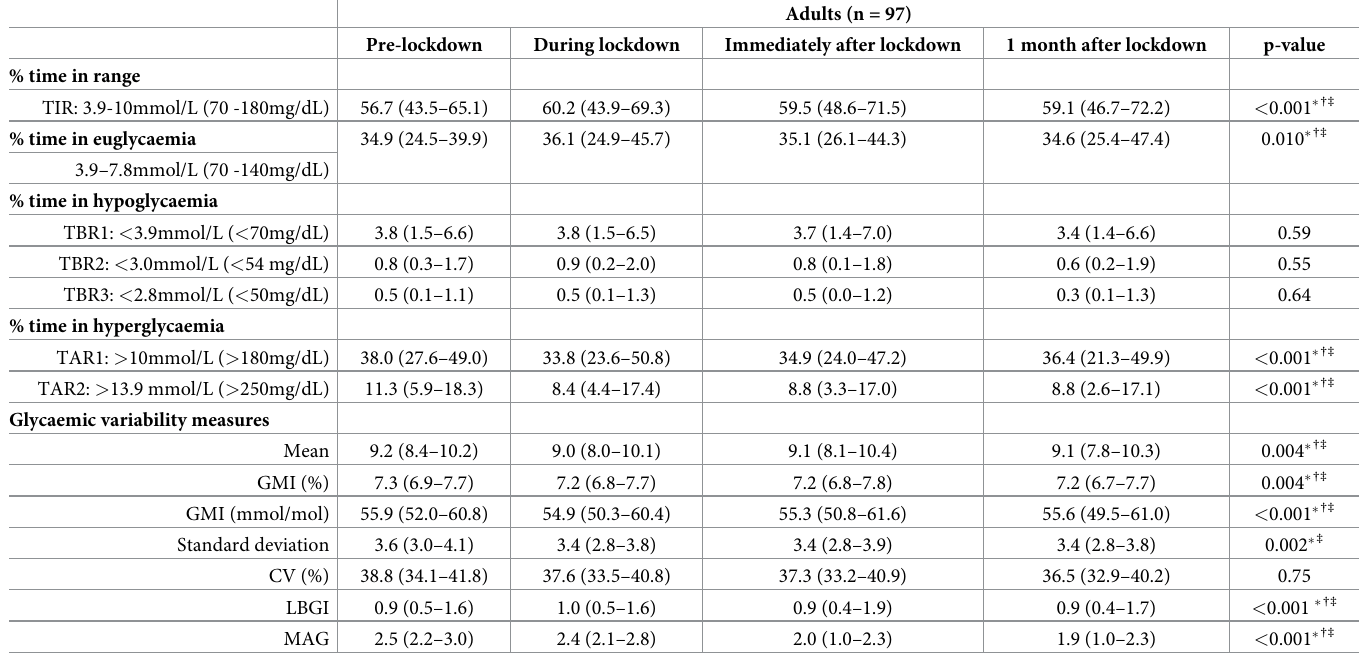
Table 4. Glycaemic outcomes in the pre-, during, immediately after and a month after lockdown (n =